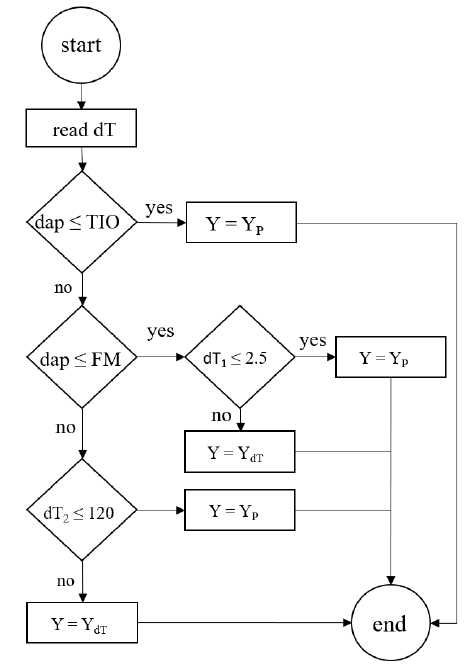
Figure 1. Scheme of the incorporation of canopy temperature into the SOLANUM model. Final values (Y) of the SOLANUM model’s growth curves were determined between potential values ( Y p ) and penalized valued ( Y dT ) according to the water stress degree based on canopy temperature depression (dT). dT 1 : average dT before irrigation pulse. dT 2 : accumulated dT from the tuber initiation onset (TIO) to physiological maturity